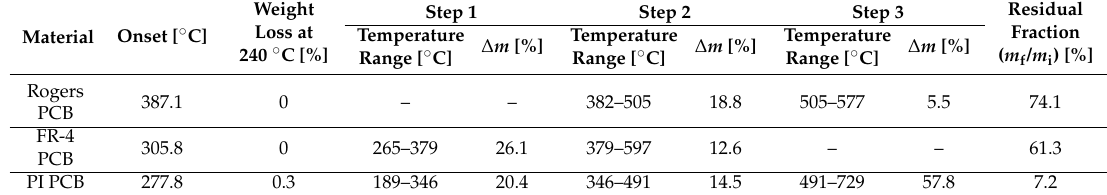
Table 2. Results from TGA measurements. m i is the initial mass of the sample and m f is the residual mass of the sample at 930 °C. PCB, Printed Circuit Board; PI, Polyimide.